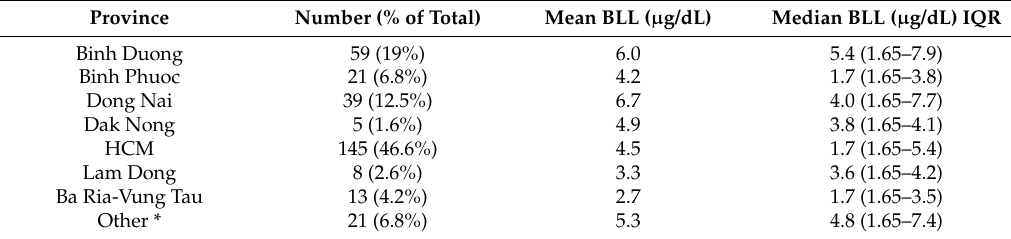
Table 2. Mean and median (interquartile range (IQR)) BLLs by